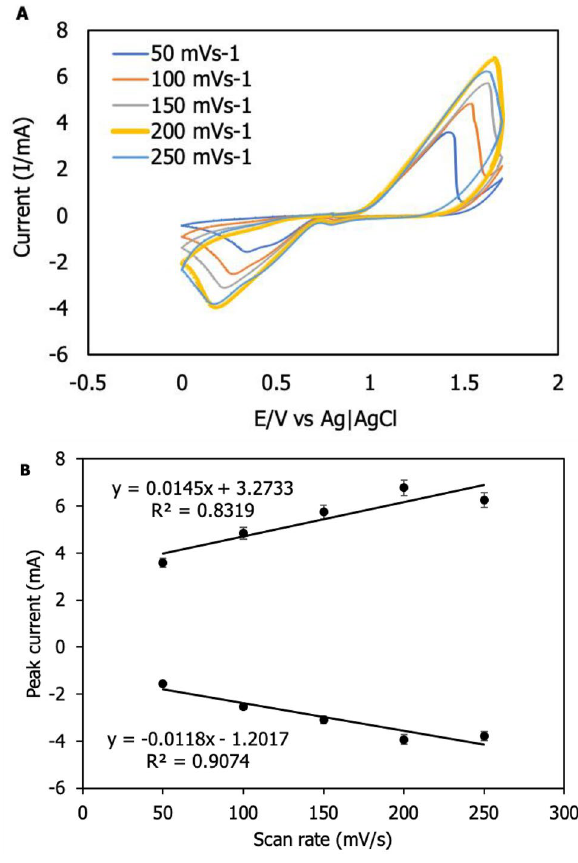
Figure 6. Effect of different scan rates tested on f-MWCNTs/CS/PB/AuE; ( A ) 50–250 mVs -1 and ( B ) Linearity of Ipa and Ipc.